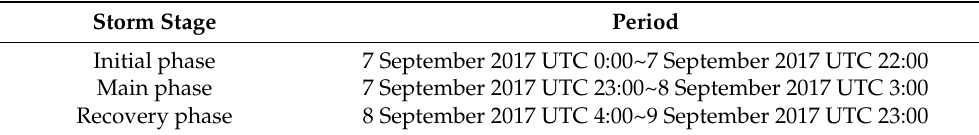
Table 2. Corresponding time of different stages of this geomagnetic storm.